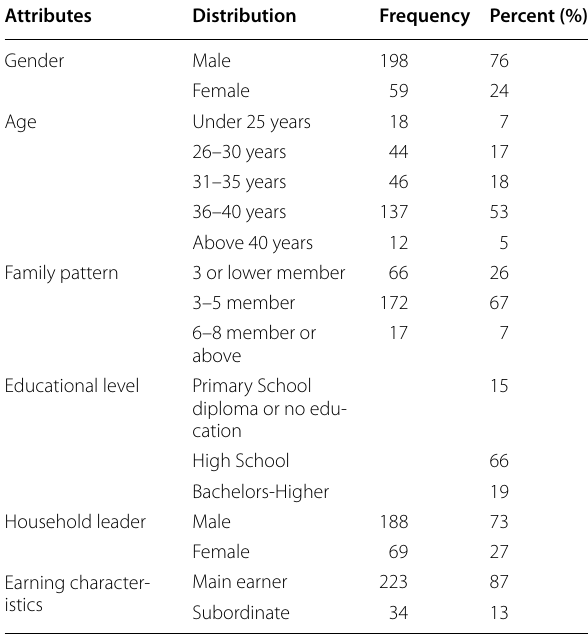
Table 2 Demographic profile of the respondents